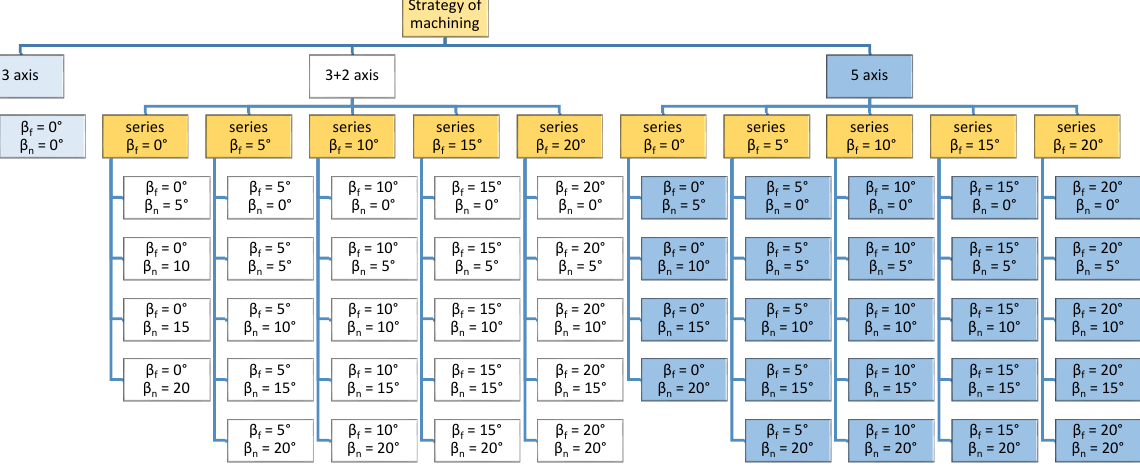
Figure 6. Chart of milling samples.